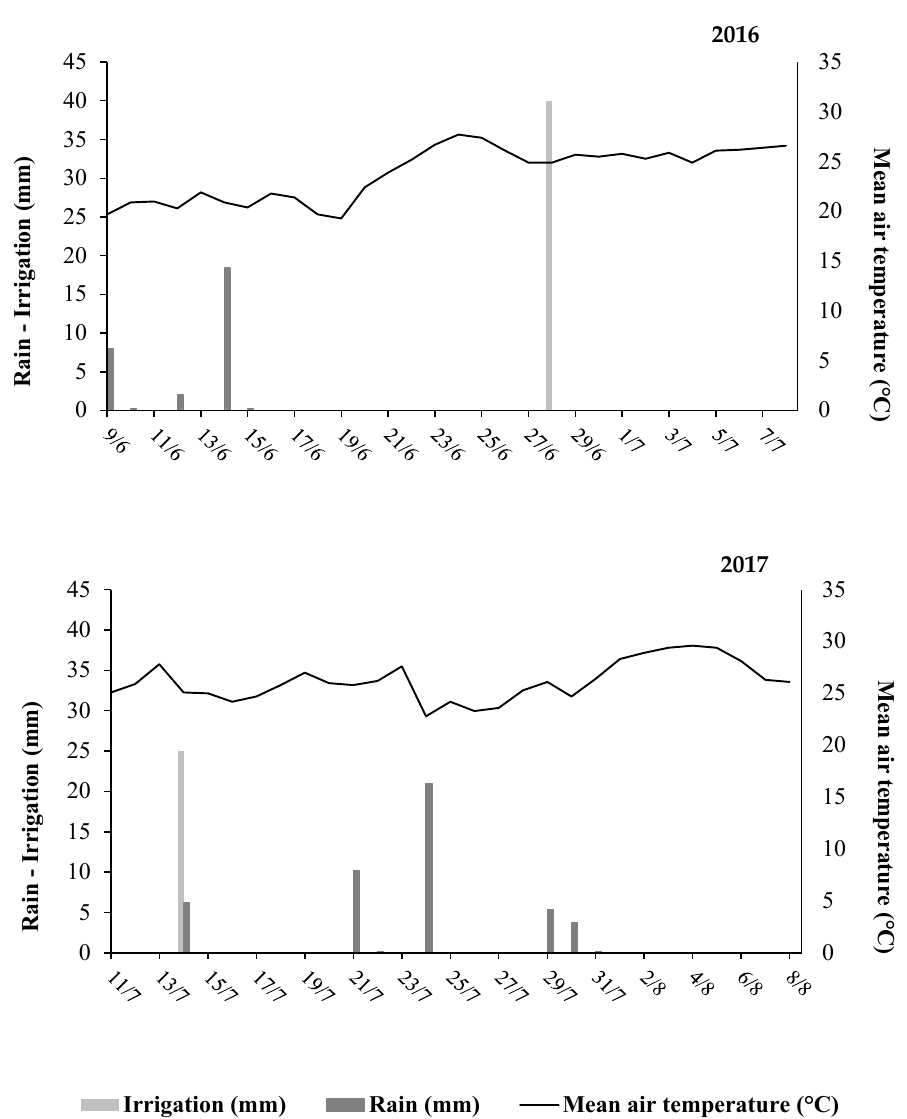
Figure 1. Mean daily air temperature, rainfall and irrigation amounts in side-dressing (2016, upper panel) and pre-sowing (2017, lower panel) fertilizations.